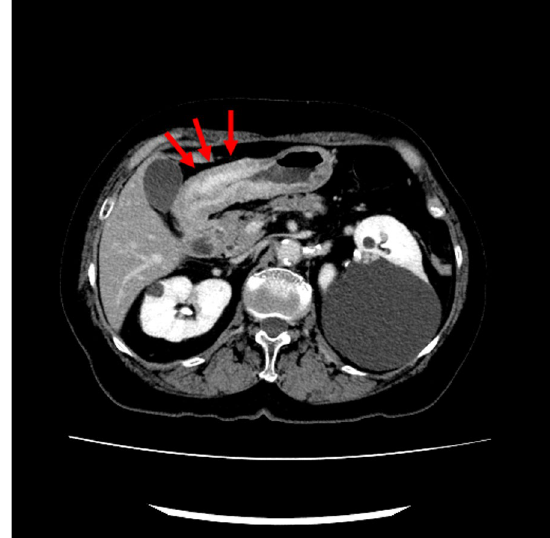
Fig. 1 Upper gastrointestinal endoscopy revealed an advanced infiltrative ulcerative tumor in the lesser curvature extending from the antrum to the middle of the body of the stomach